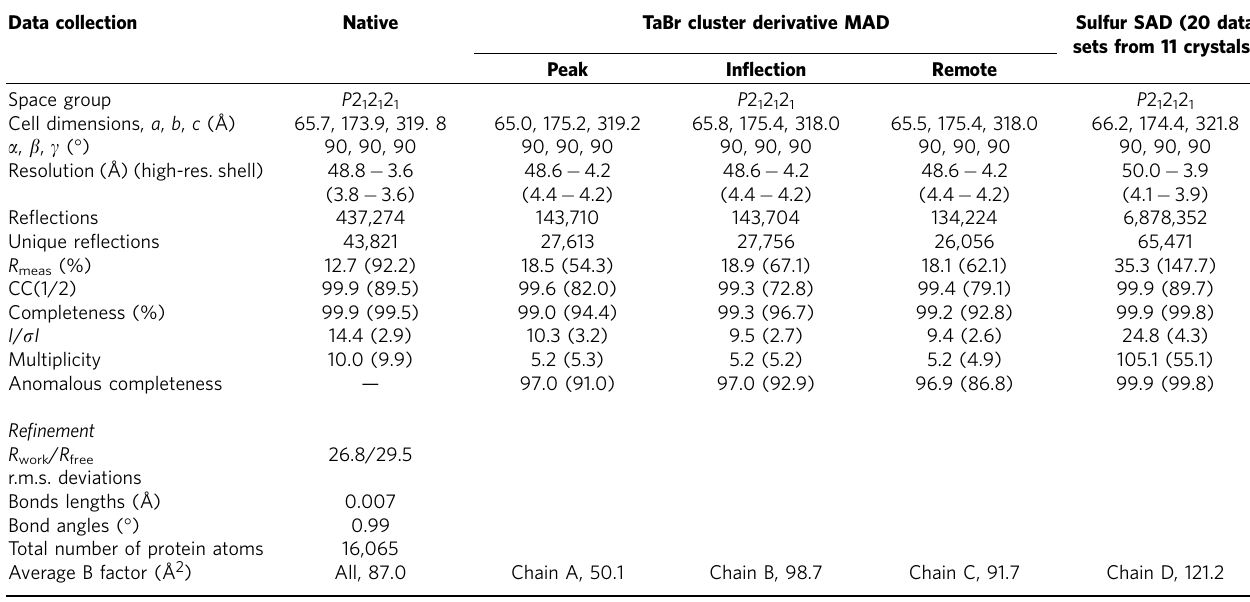
High res., high resolution; MAD, multiple wavelength anomalous dispersion; SAD, single wavelength anomalous dispersion.